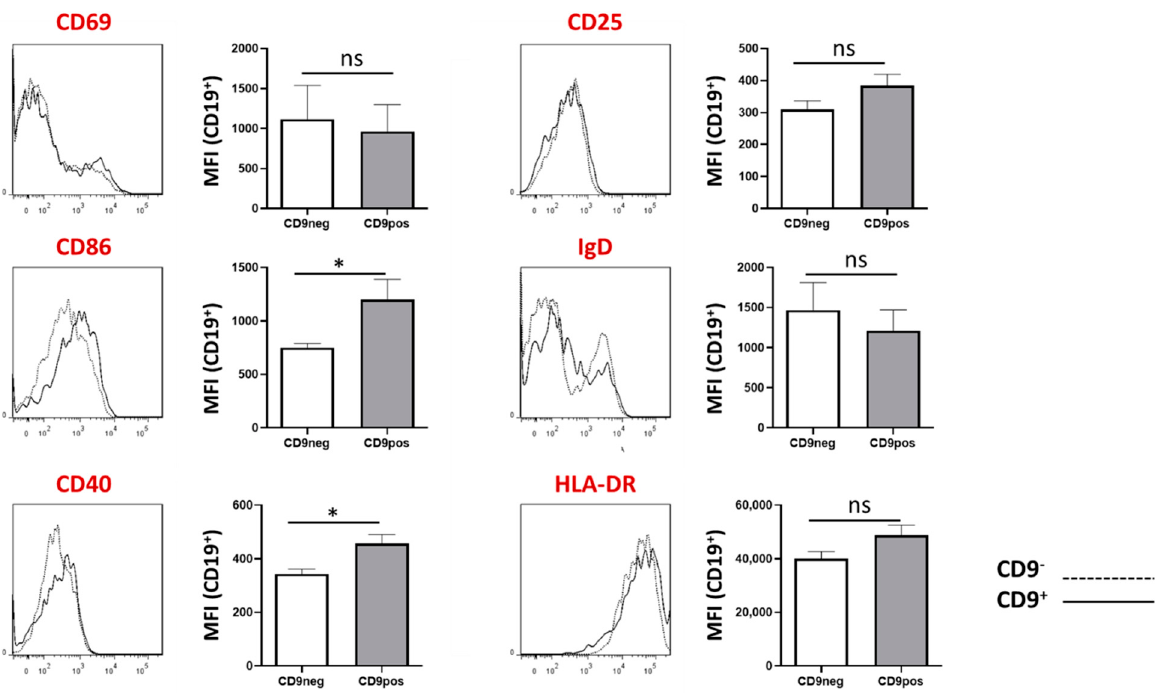
Figure 6. Expression of B cell markers in CD9 - and CD9 + B cell. Total tonsil cells were stained for CD19, CD9, CD69, CD86, CD40, CD25, IgD, and HLA-DR then subjected to flow cytometry analysis, of which live CD19 + was gated, followed by CD9 - and CD9 + . Greater expression of CD86 and CD40 were detected within CD9 + B cells as compared to CD9 - B cells. * p < 0.05, ns (non-significant) p > 0.05. Solid line, CD9 + B cells; dotted line, CD9 - B cells. Student’s t-test (unpaired) was performed to determine statistical significance.